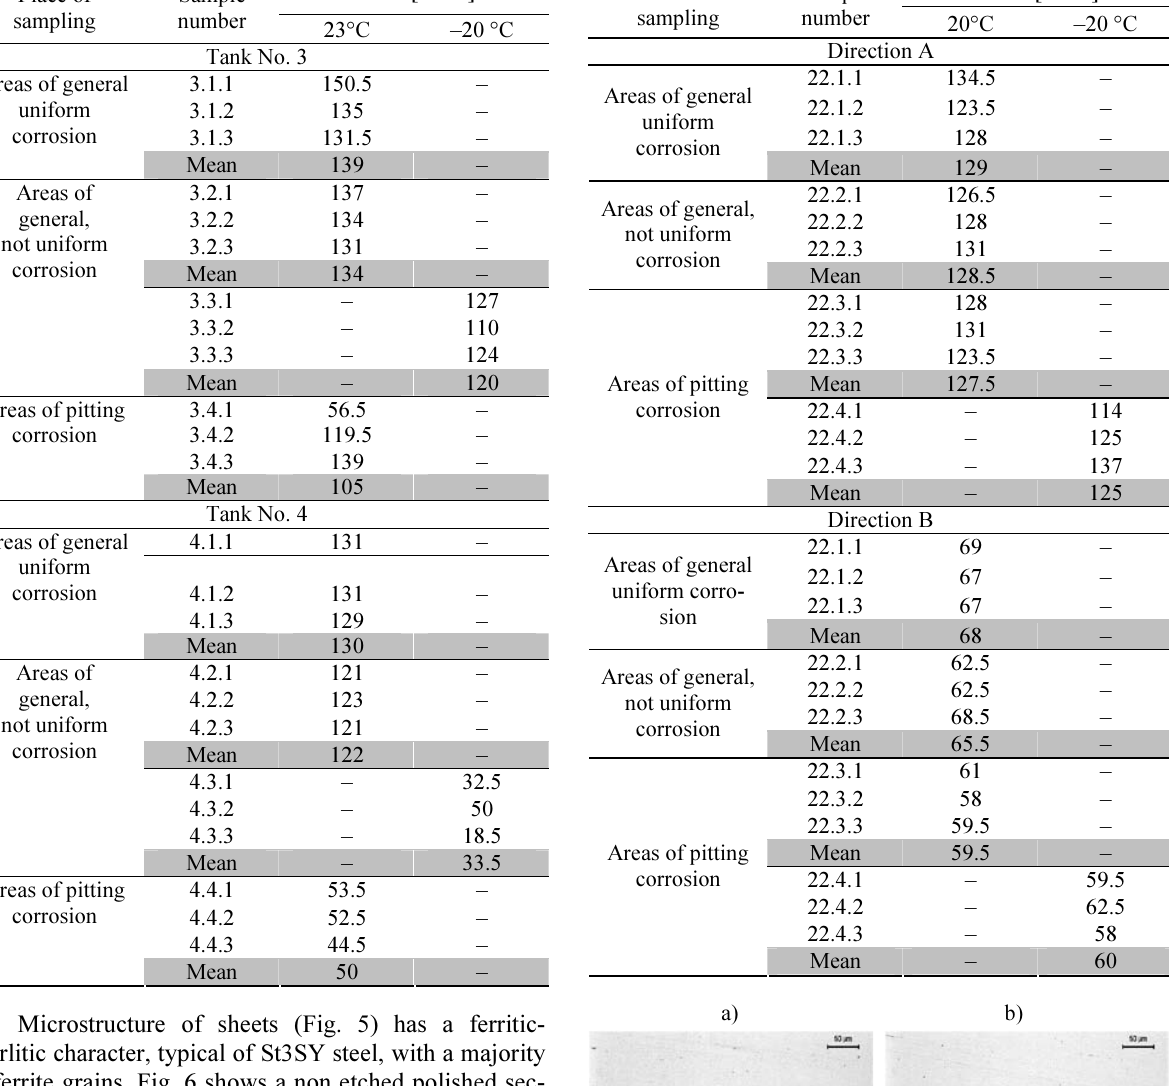
Table 3. Results of KCV impact resistance test for steel from